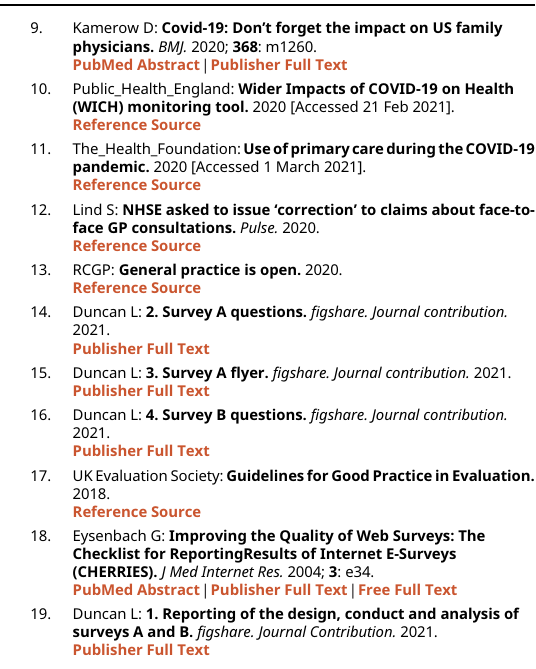
Figshare: Survey A flyer, https://doi.org/10.6084/m9.figshare.14269475.v1 15